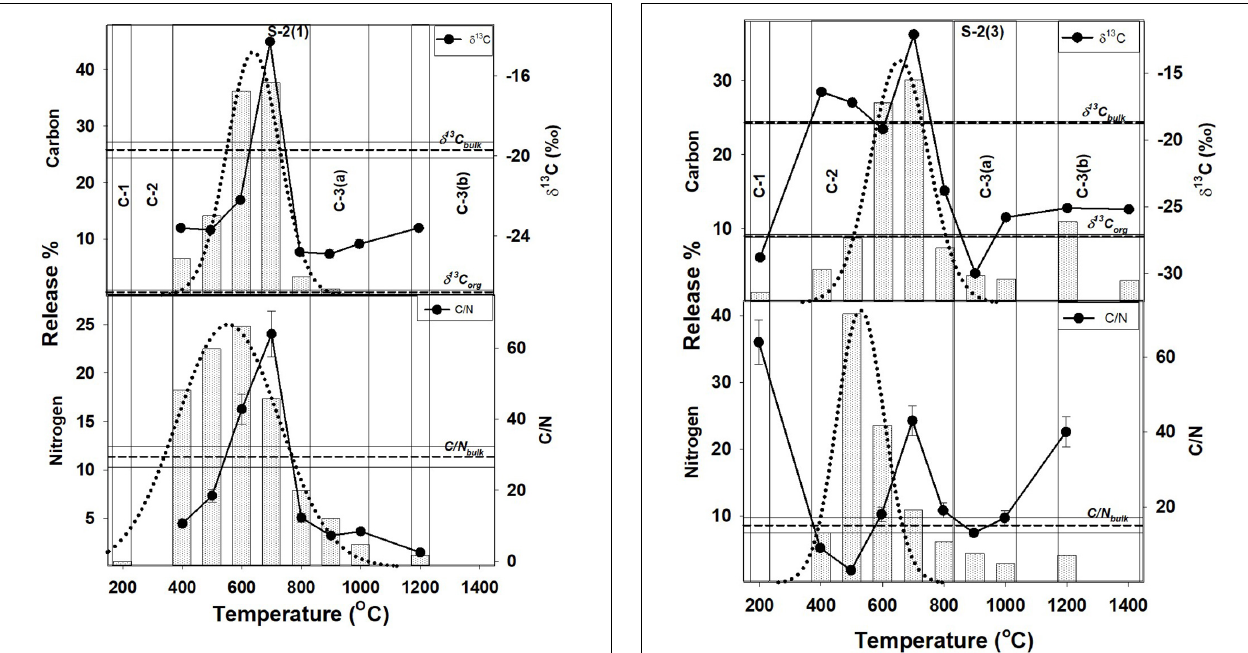
conduits (Santarelli and Carminati, 1995; Wilson and